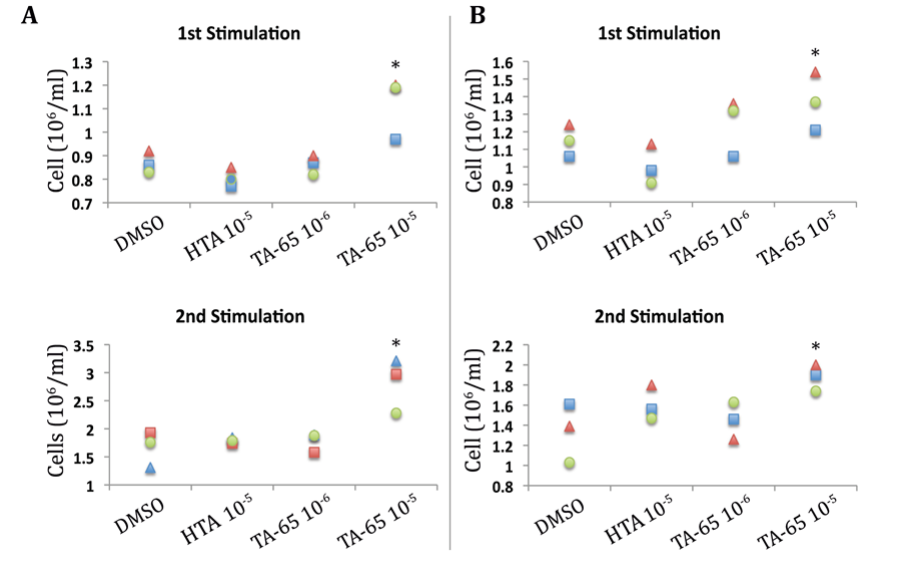
Figure 4. Proliferation effects of TA-65 and HTA: Cell counts were determined on day 3 after stimulation. A, represents results for CD4 T cells and B represents results for CD8 T cells (concentrations are 10 6 /mL). A and B top, represents actual cell concentration after first T cell stimulation, A and B bottom represents total cell concentration after second stimulation. Statistical significance was determined by student paired t test ( p <